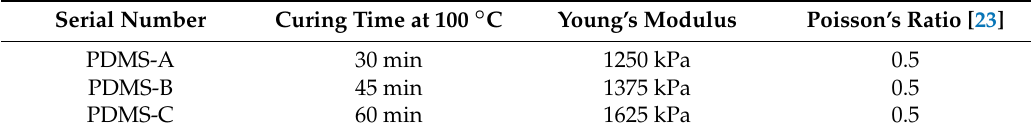
Table 2. Mechanical properties of PDMS diaphragm with different curing times.